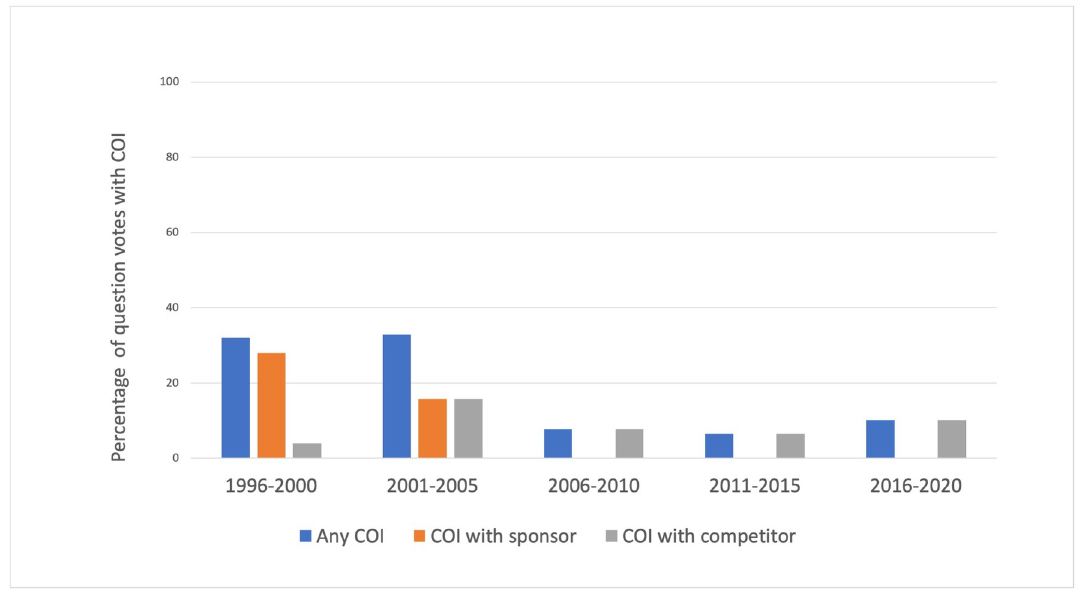
Fig 1. Percentage of votes at Gastrointestinal Drug Advisory Committee meetings with member conflict of interest, stratified by 5-year time intervals.